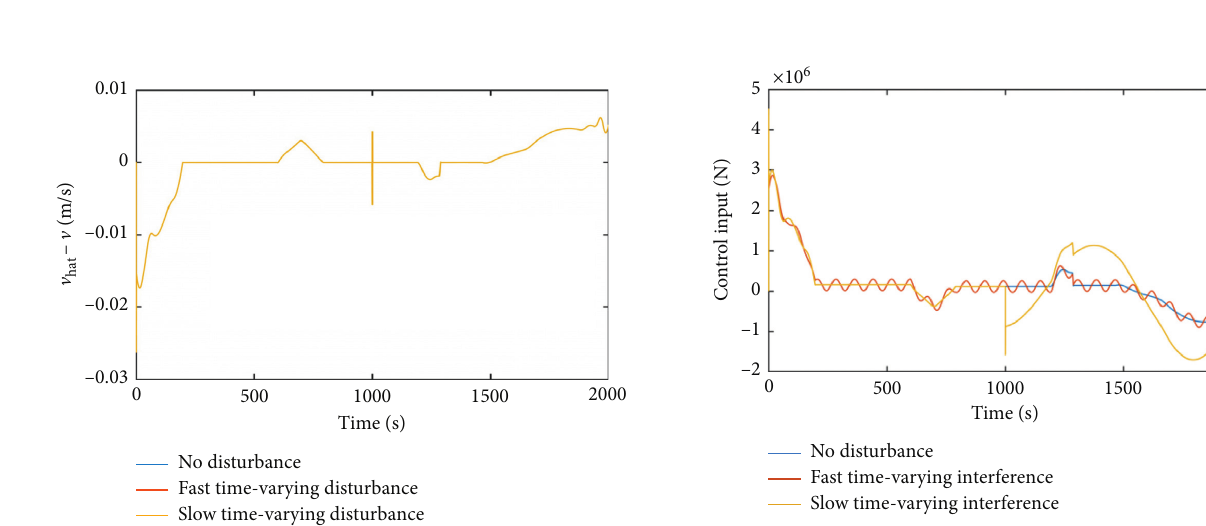
Figure 18: Control input with different